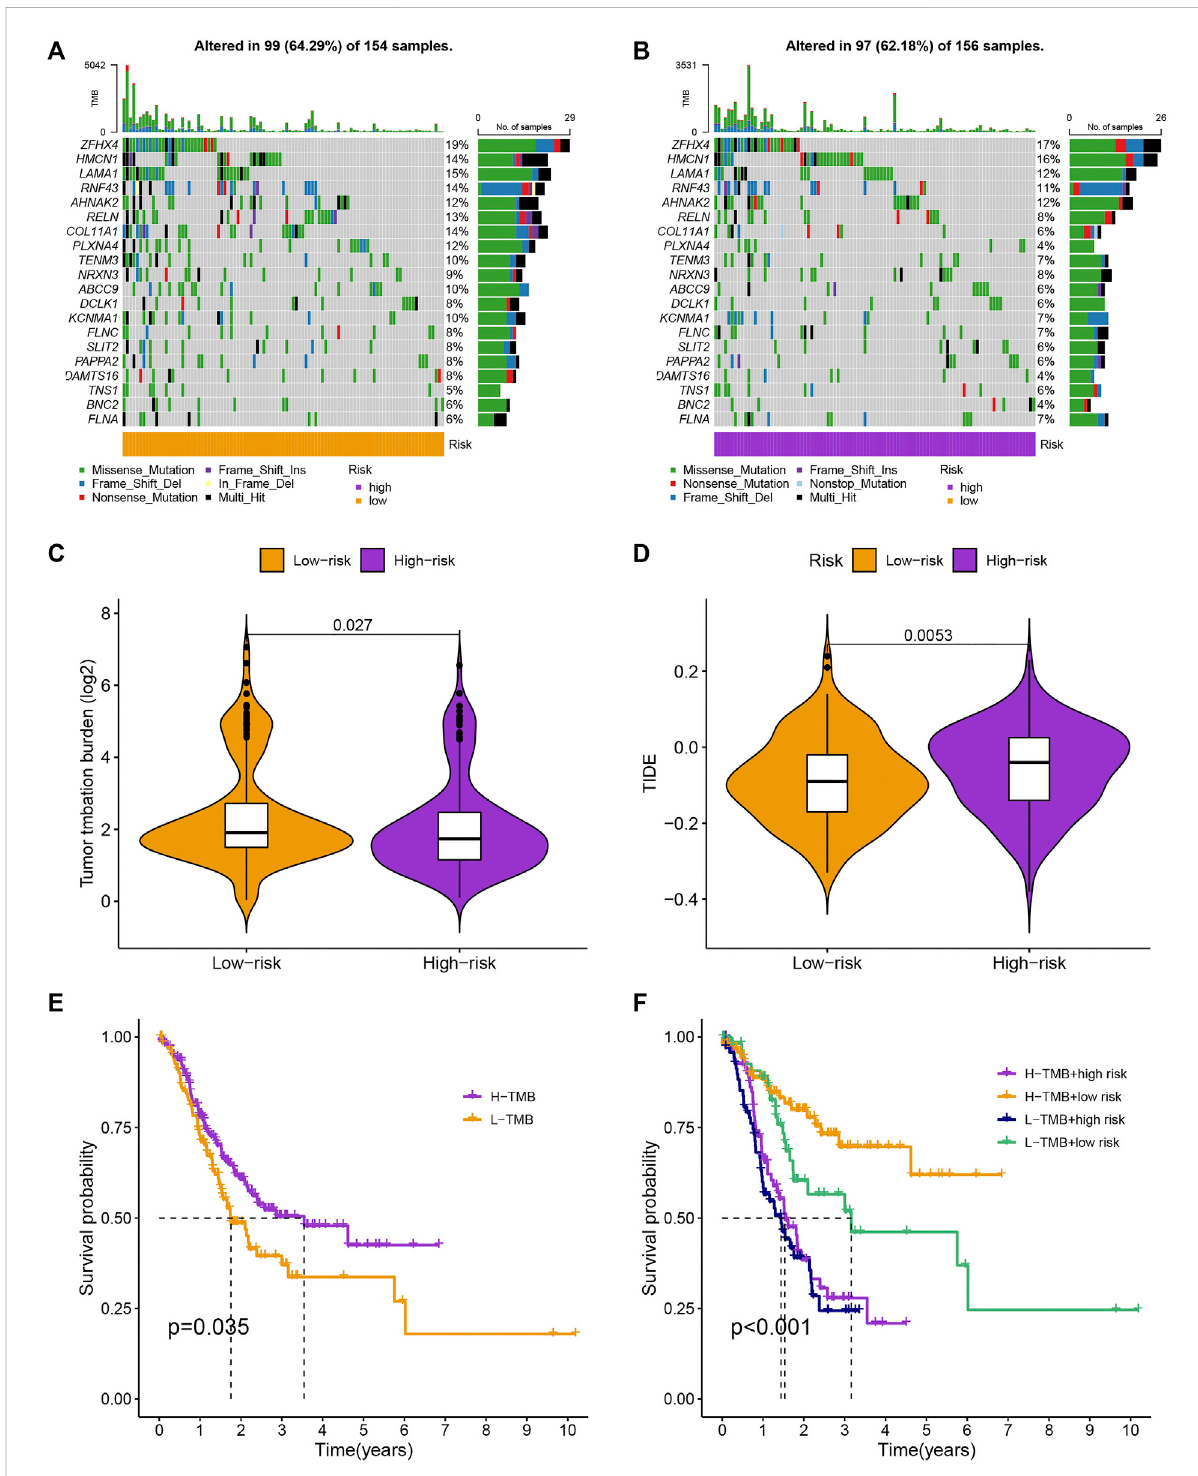
FIGURE 7 Evaluation of cancer immunotherapy response. (A,B) More genes were mutated in the high-risk group. (C,D) Comparation of the immunotherapy response of the different-risk group to predict TIDE and TMB. (E,F) The SP of patients in different